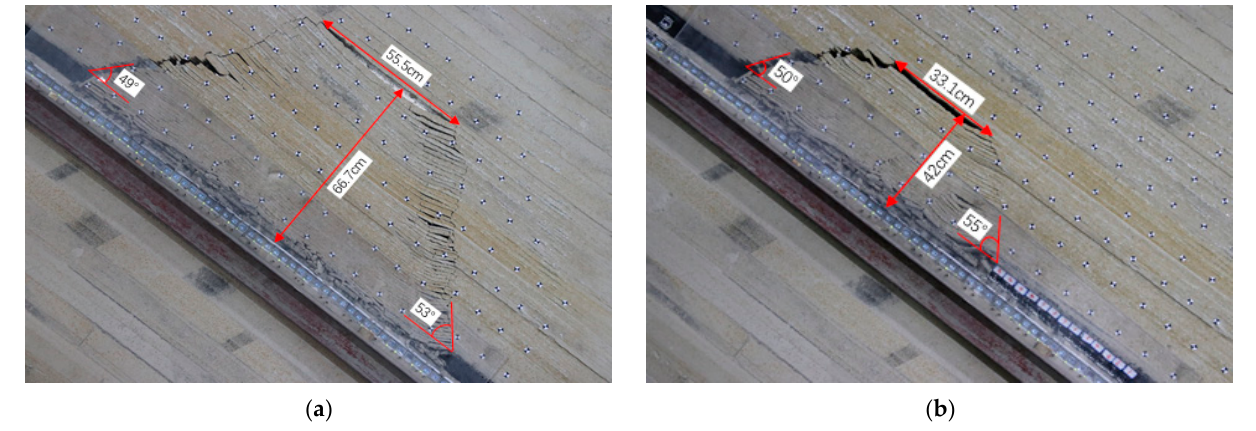
Figure 12. Collapse form of the overburden. This figure shows the height, inclination angle, and the top length of the collapse in no filling and filling 1/3, respectively. ( a ) No filling; ( b ) Filling